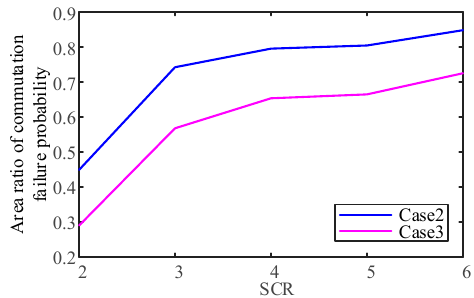
Figure 9. Area ratio of commutation failure probability in different cases under single phase to ground fault.